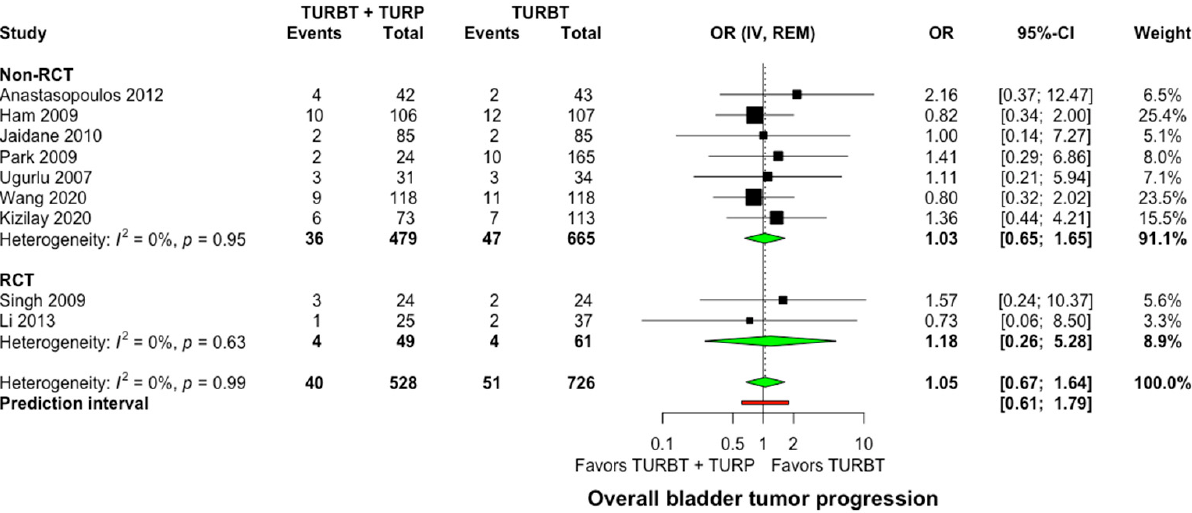
Figure 4. Forest plot comparing concomitant TURBT and TURP versus TURBT in terms of bladder tumor progression. CI: confidence interval; IV: inverse variance; OR: odds ratio; RCT: randomized controlled trial; REM: random-effects model; TURBT: transurethral resection of bladder tumor; TURP: transurethral resection of the prostate.